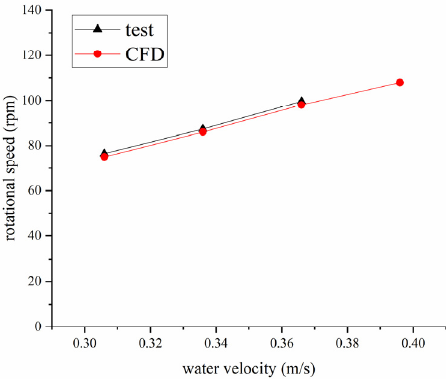
Figure 10. Rotational speed with v at δ s = 40 ◦ , θ = − 3 ◦ . Table 2. Rotational speed from tests and